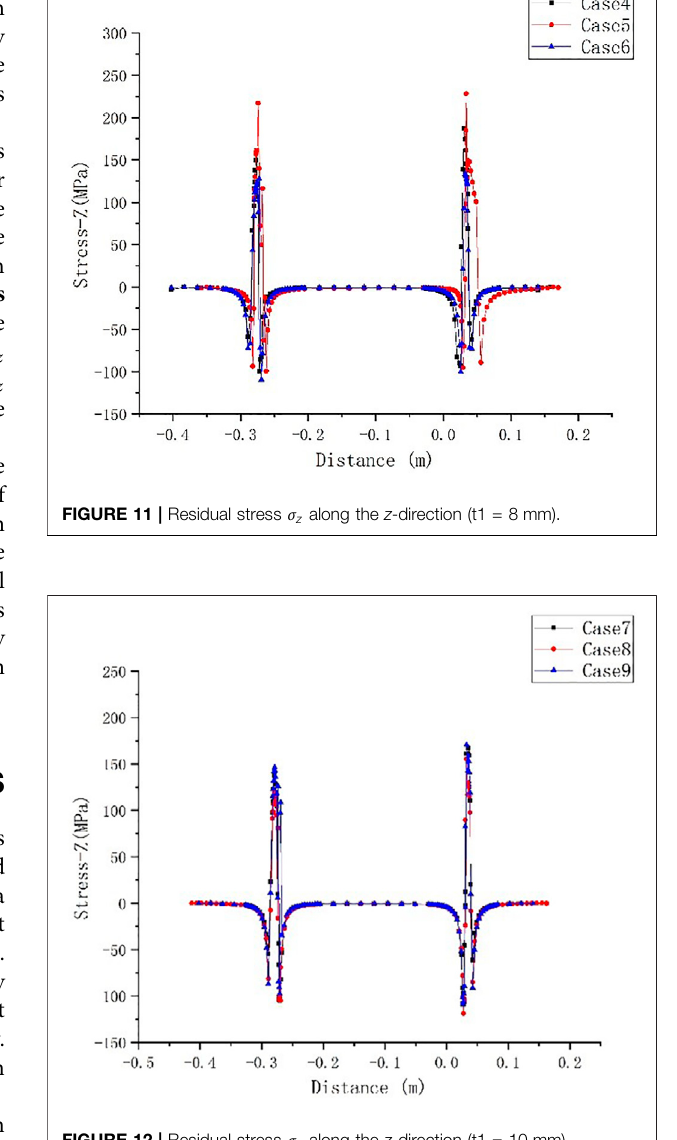
FIGURE 12 | Residual stress σ z along the z -direction (t1 = 10